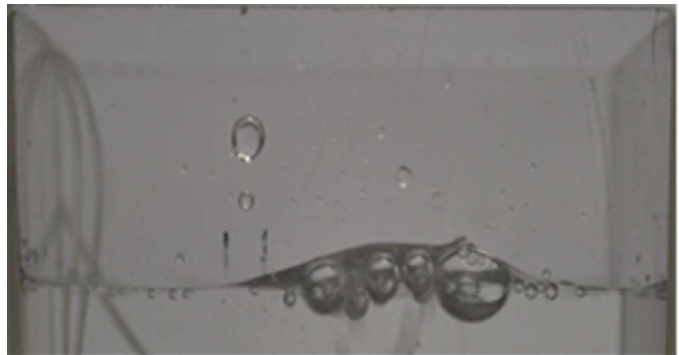
Figure 4. Examples of air bubble images for pure water.